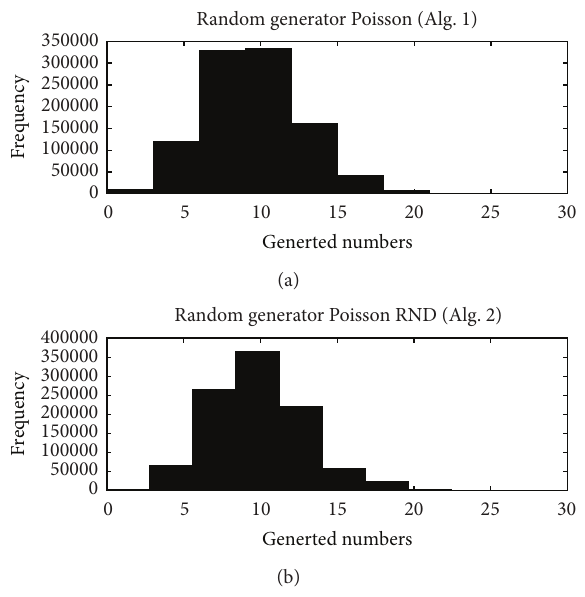
Figure 2: General approach of event generation, detection, and